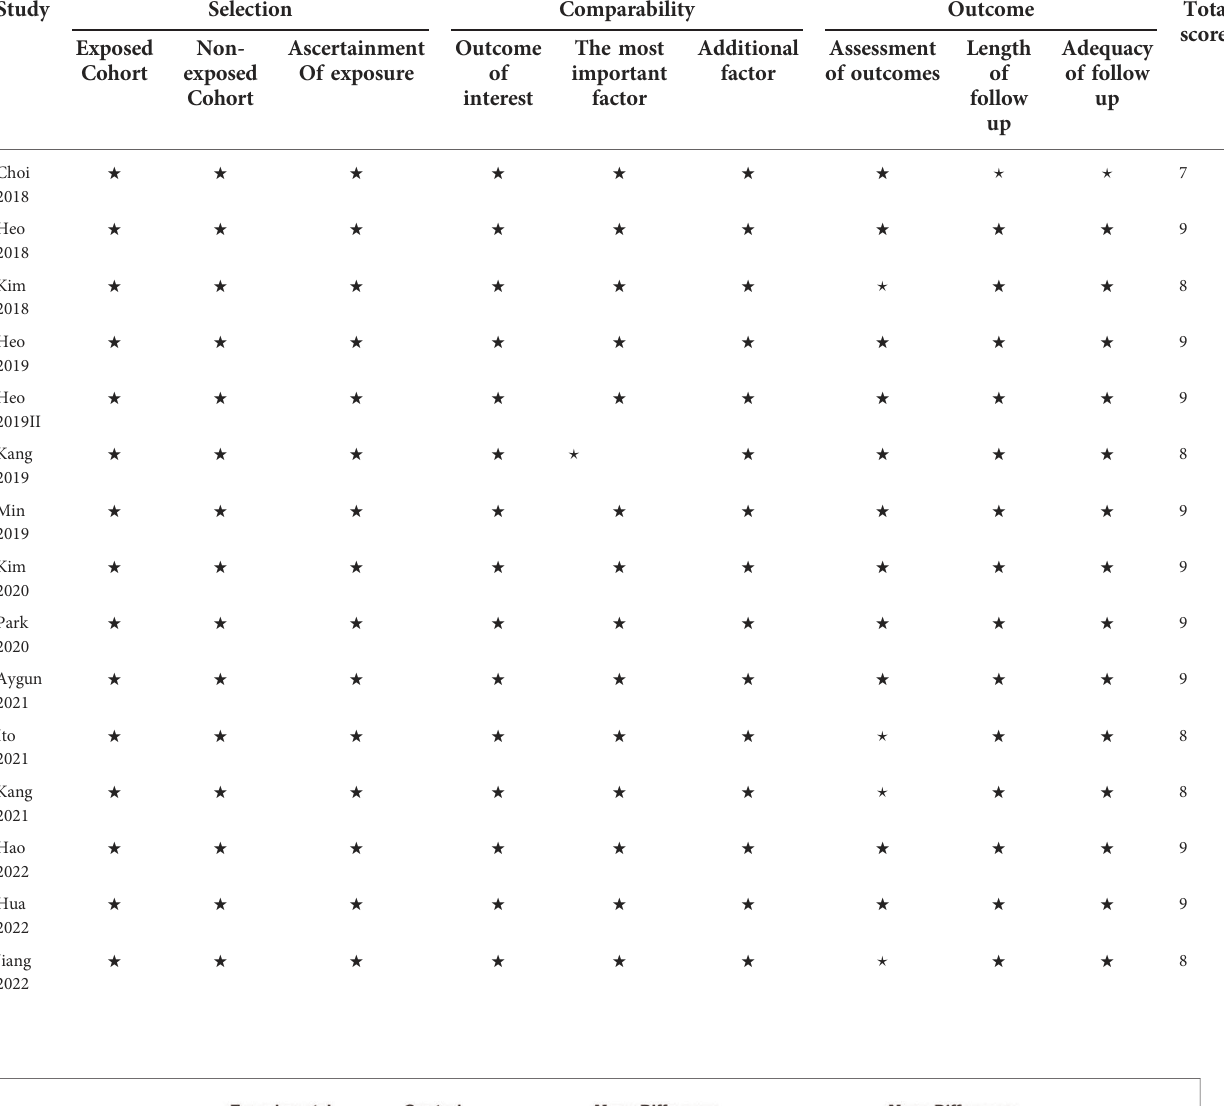
TABLE 2 Risk of bias assessment using the Newcastle – Ottawa Scale for observational studies. Study